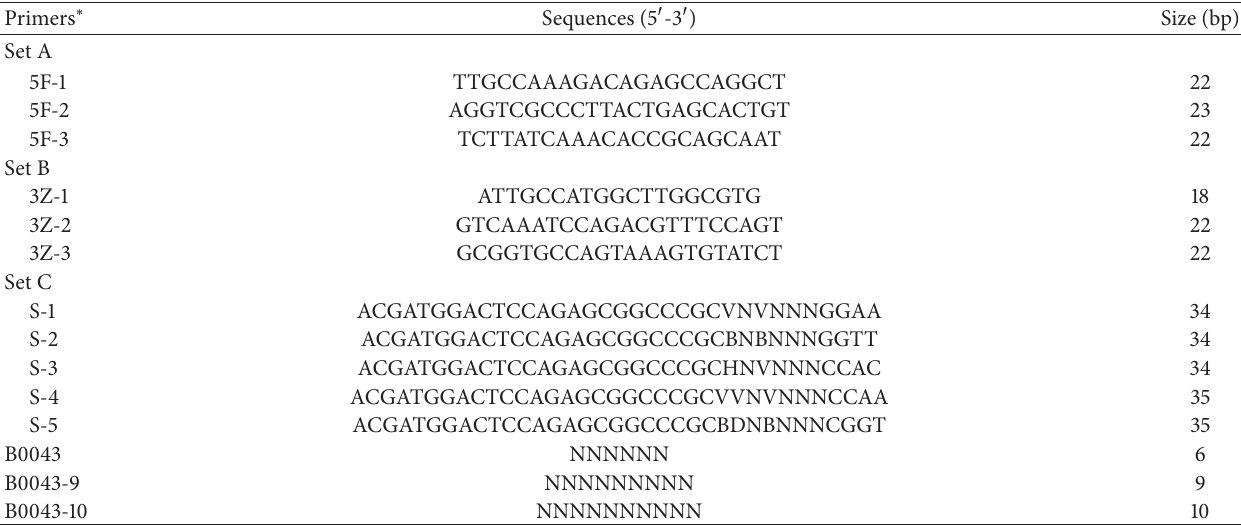
Table 3: Primers used in cloning of 5 󸀠 and 3 󸀠 flanked sequences of LAAO gene from Pseudoalteromonas sp. B3. Primers